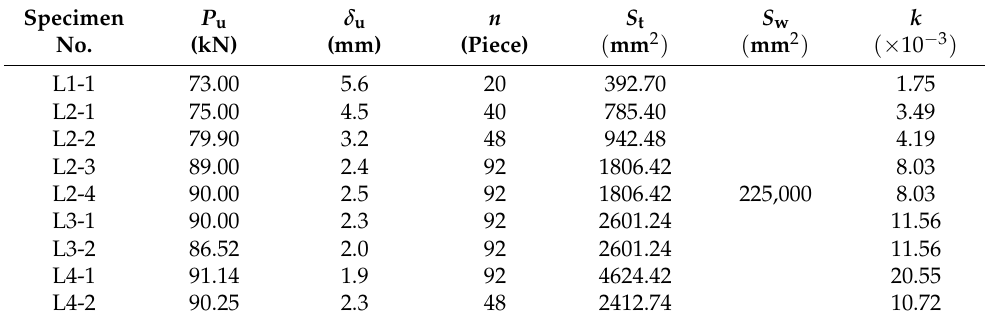
Figure 12. The load–slip curve.